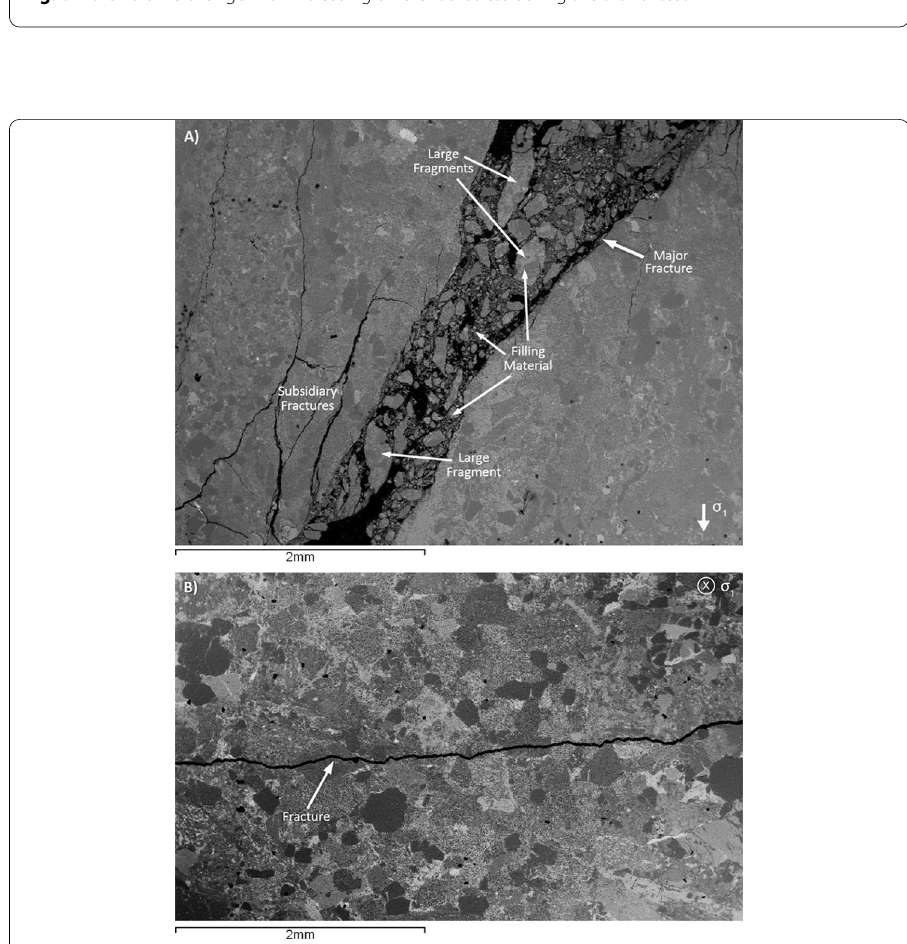
Fig. 7 A SEM image of the greywacke sample TTGW_11_3 brought to failure in triaxial conditions. The deformed sample was mounted in epoxy resin and cut and polished for imaging within the SEM. This image displays the shear fracture and its filling material. A microfracture network is visible to the left side of the primary shear fracture. B SEM image shows an induced Mode I fracture in a greywacke disk (TTGW_11_3_17) using the Brazilian jig. The fracture is both intergranular and